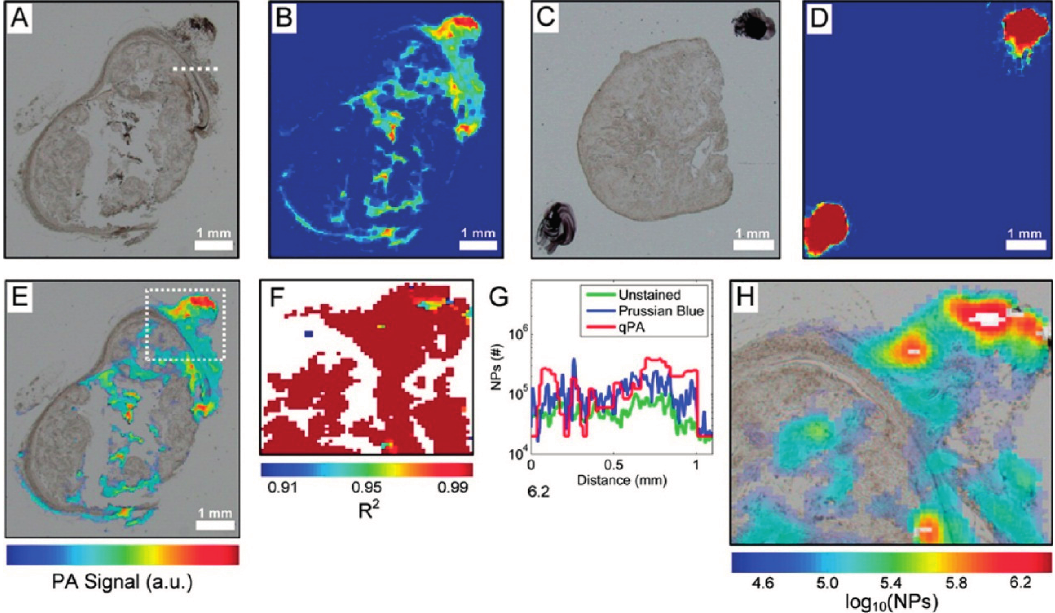
Figure 4. Bright-field microscopy ( A , C ) and photoacoustic (PA) ( B , D ) images of unstained tumor slices with ( A , B ) and without ( C , D ) NPs. An overlay of the optical and PA image of the tumor with NPs from ( A ) and ( B ) are shown in ( E ). R 2 map of the area in the white box in ( E ) is shown in ( F ); Quantitative PA image using R 2 > 0.97 with unquantifiable areas in white is shown in ( H ); ( G ) Quantitative comparison of the unstained and Prussian blue stained bright-field images and the qPA images. The values for the graphs were generated from a line shown in ( A ). Reprinted with permission from Cook et al . [171] Copyright 2015 American Chemical